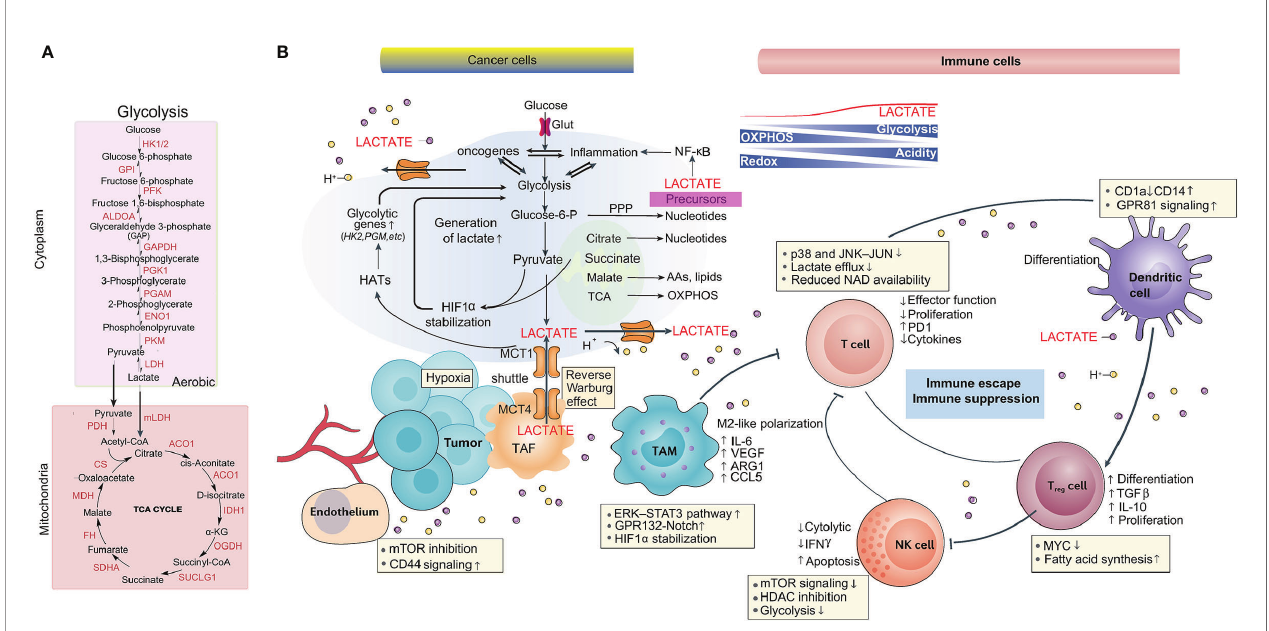
FIGURE 1 | Lactate metabolism is implicated in the tumor microenvironment. (A) The main biochemical players in lactate generation: the glycolytic pathway and OXPHOS. (B) Role of lactate in the TME, including tumor, stromal, immune cells, blood vessels and cellular metabolites such as lactate. As a consequence of the Warburg effect and the lactate shuttle, lactate accumulation induces acidosis, angiogenesis, immunosuppression, and tumor cell proliferation and